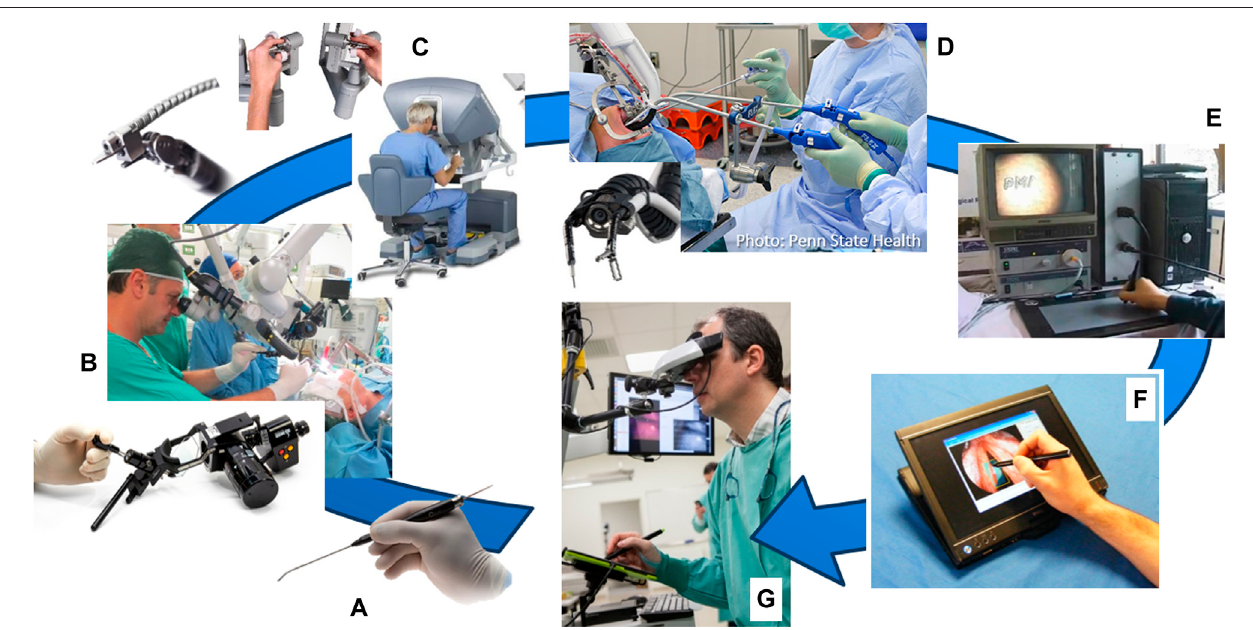
FIGURE1| Userinterfacesforlasersurgery. (A) ElevateENThandpiece,anopticalscalpelcommercializedbyOmniGuideSurgical. (B) EasySpotHybrid,amanual lasermicromanipulatorbyDEKAforsurgicalmicroscopes. (C) IntuitiveSurgical ’ sdaVincisystemand (D) MedroboticsFlexroboticsystem,bothofwhichcanincludean optical fi ber for laser surgeries. (E) K.U. Leuven ’ s interface for robot-aided laser surgery based on a graphics tablet (Tang et al., 2006). (F) IIT ’ s Virtual Scalpel interface based on a tablet PC (Mattos et al., 2011). (G) µRALP ’ s Virtual Microscope and tablet-based laser controller (Deshpande et al., 2014).